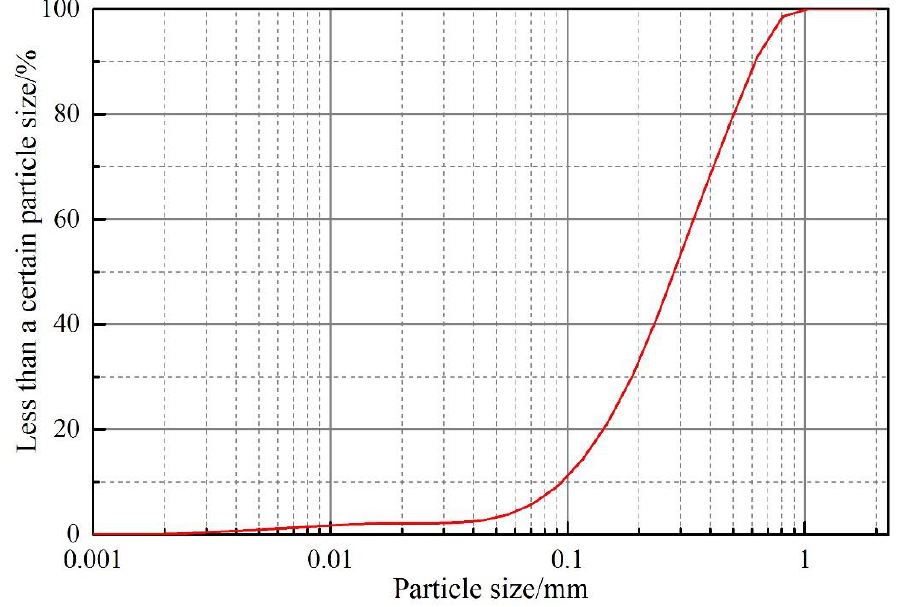
Figure 2. Logarithmic probability particle gradation curve.